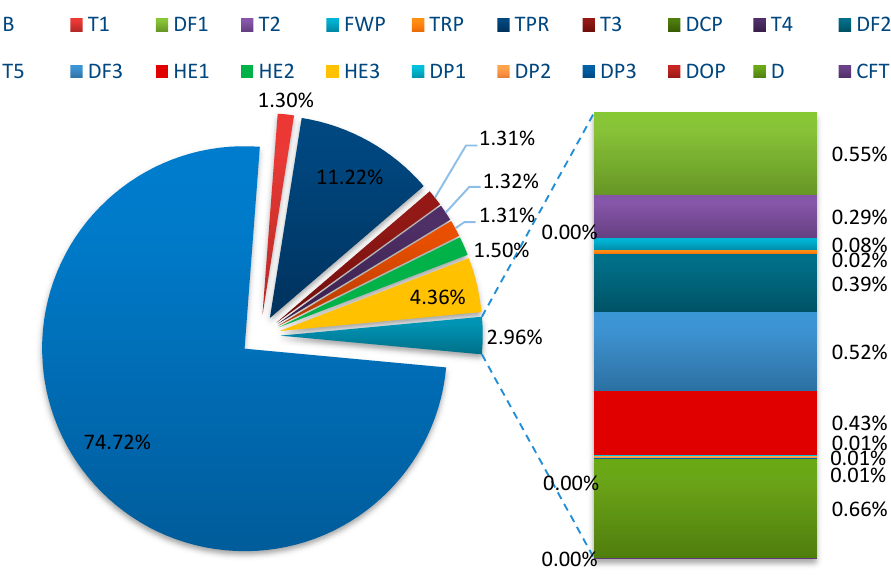
Figure 4. Percentage of each component's exergy loss of the total exergy loss.